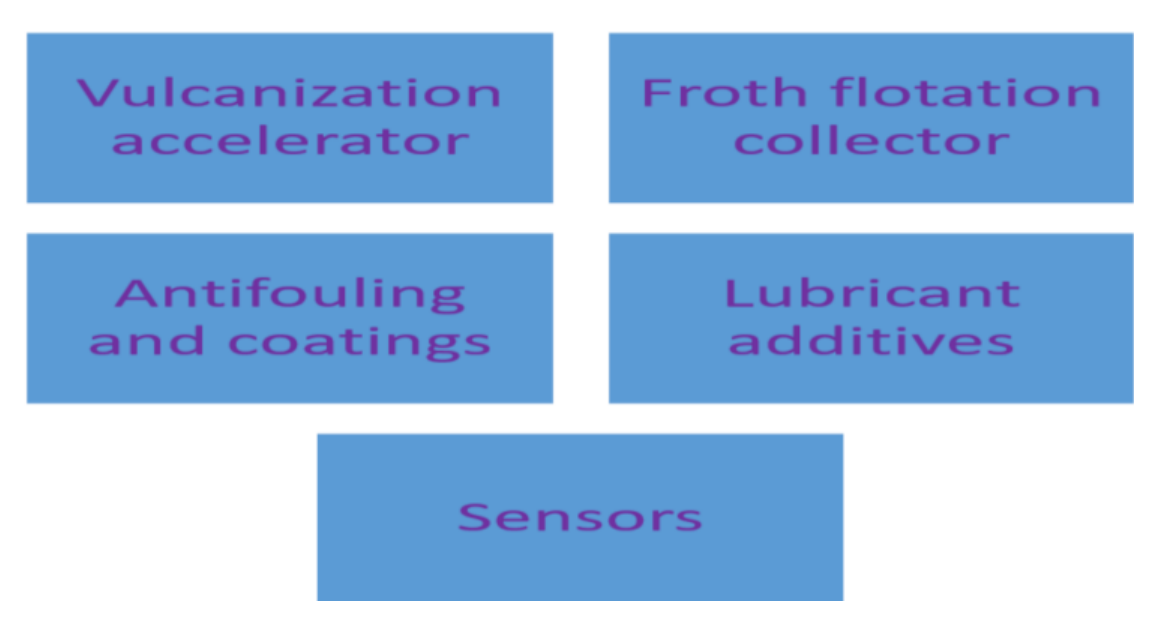
Figure 11. Industrial applications of